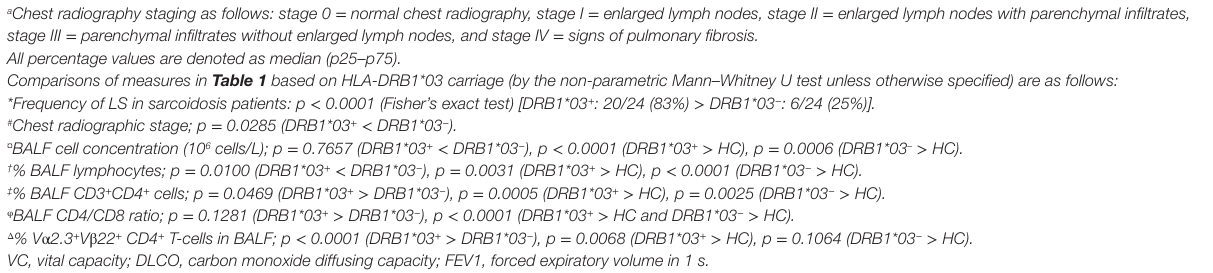
among all sarcoidosis patients ( n = 48)